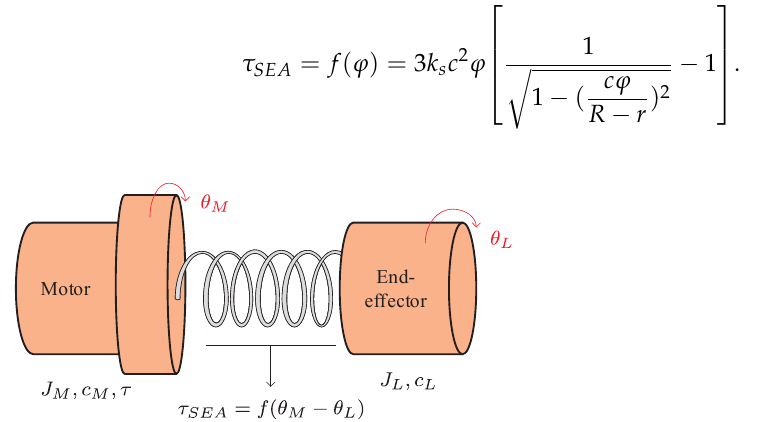
Figure 5. Model of the SEA (the end-effector connects to Rod